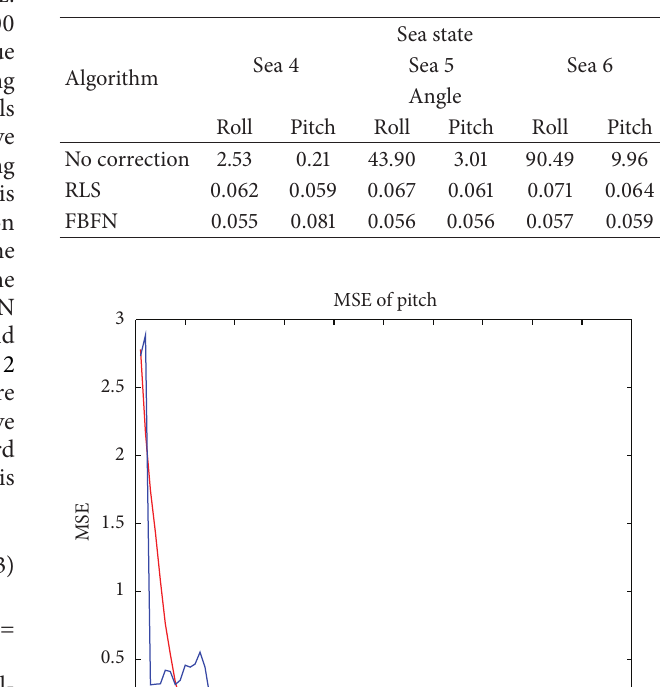
Table 2: Comparison of the convergent values for different sea states.